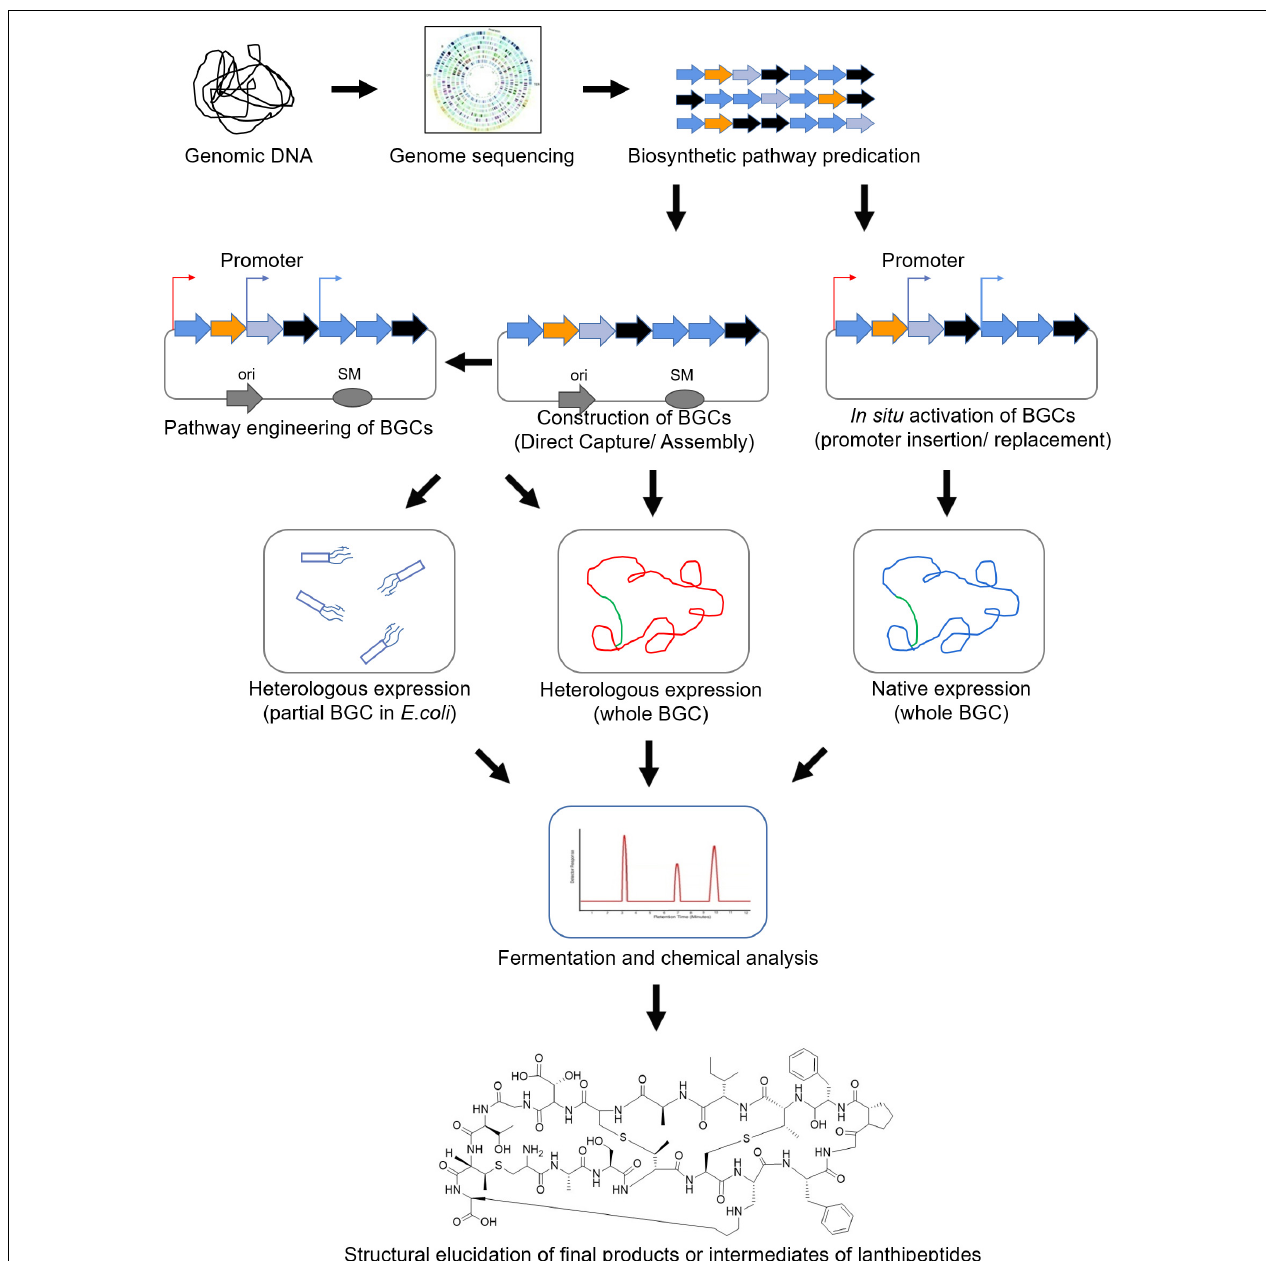
FIGURE 4 | Scheme of genome mining of